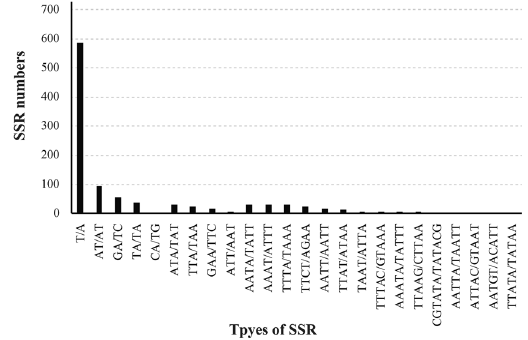
Figure 2. Frequency of simple sequence repeats (SSRs) in the sixteen Lilium chloroplast genomes.